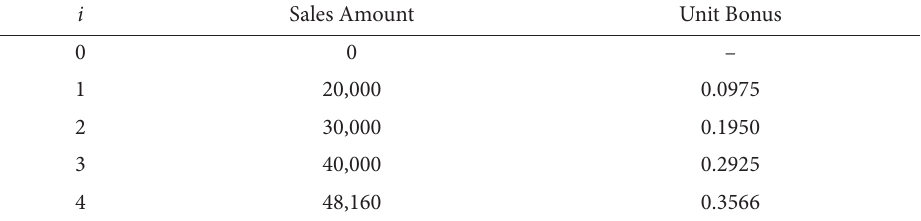
Table 9. Unit bonuses of vendor 0345 for